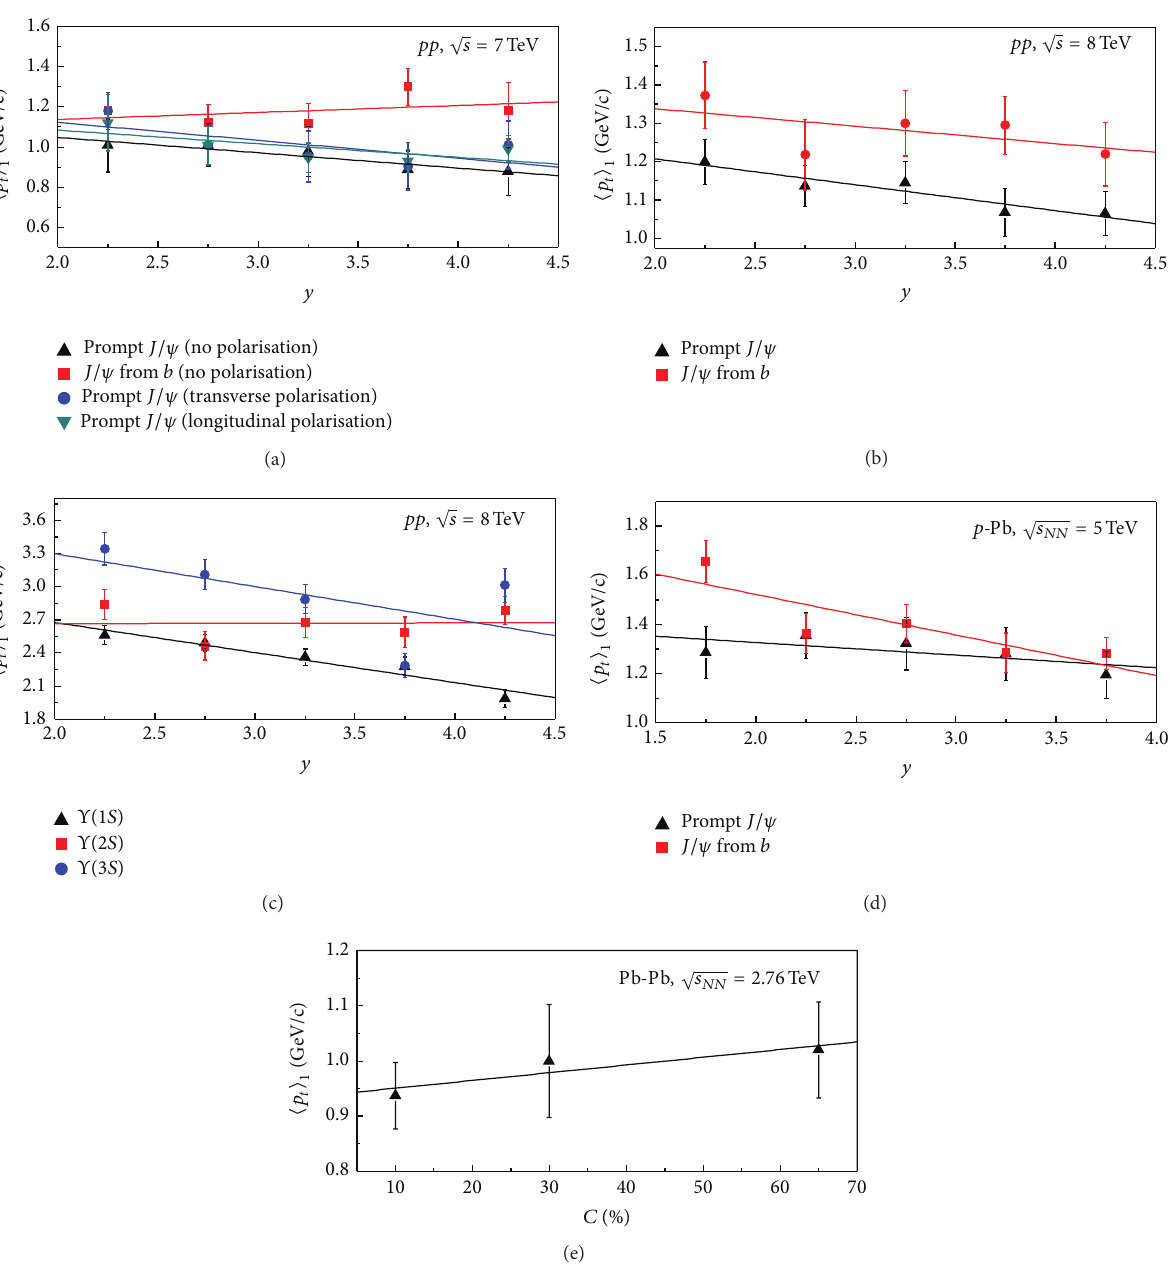
⟨𝑝 ⟩ ⟨𝑝 ⟩ 𝑘 𝜅 𝜅 𝐸1 , 𝑡 1 , 𝑡 2 , 𝑆1 , 1 , and 2 , respectively. In these figures, the symbols and lines are parameter values and fitting lines, respectively. The intercepts, slopes, and 𝜒 2 / dof related to the lines in Figures 6–11 are listed in Table 2. In the error range, 𝑘 𝐸1 and 𝑘 𝑆1 do not show obvious change with rapidity, centrality, energy, and size. ⟨𝑝 𝑡 ⟩ 1 , ⟨𝑝 𝑡 ⟩ 2 , 𝜅 1 , and 𝜅 2 do not show obvious change with rapidity and centrality, or they decrease slightly with increases of rapidity and